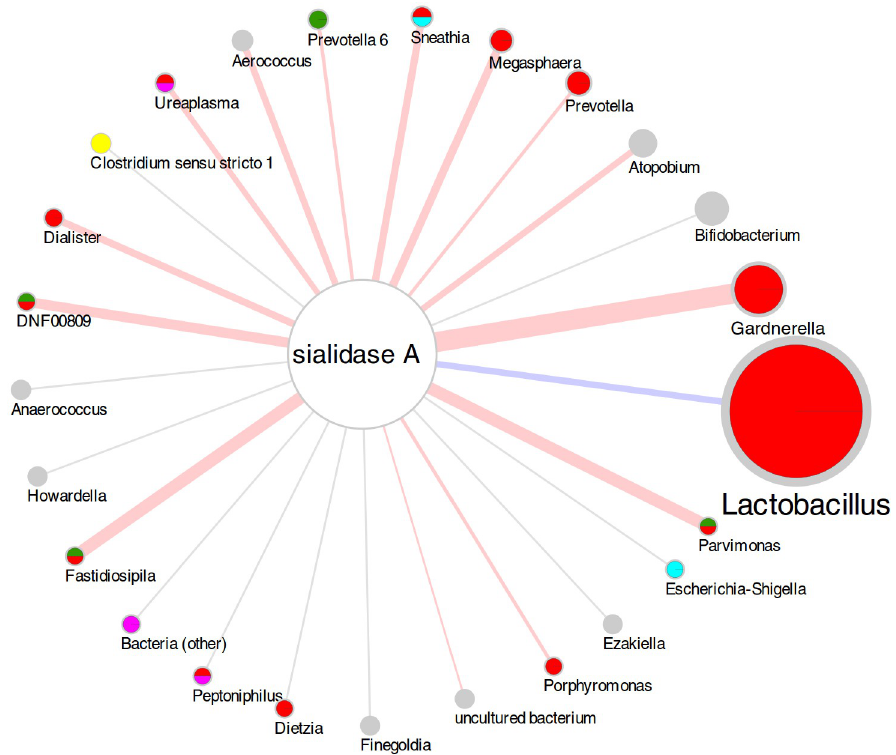
Fig 4. Diagram representing the correlations between bacterial genera and the number of copies of the sialidase gene, on a log 2 scale. Edge color represents the sign of the correlation (blue = negative, red = positive, gray = not significant) and edge thickness represents the strength of correlation. Node and label size of the bacterial genera is proportional to the average abundance over the whole set of samples. Piecharts in each node indicate whether the genera was differentially abundant in samples positive or negative for each GV clade (green = clade 1; red = clade 2; cyan = clade 3; magenta = clade 4). Colors are the same as the clades in Fig 3. Data used for building the figure are provided in S5